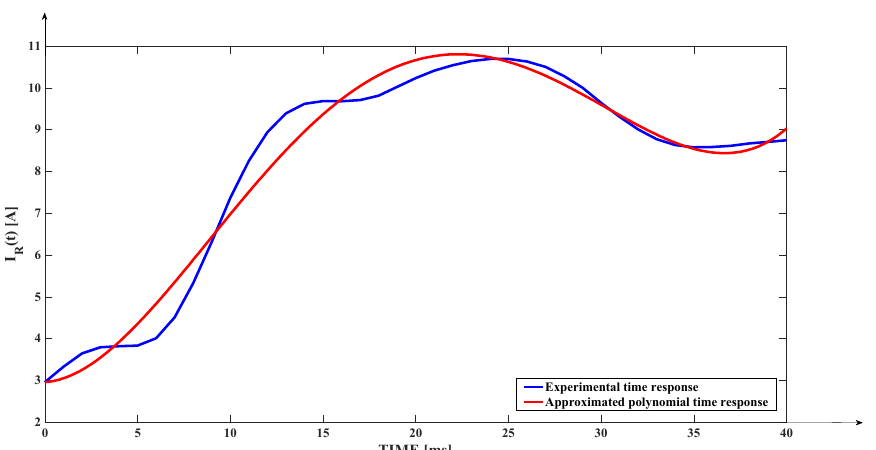
Figure 9. Comparative graph between the experimental response I R (t) and the response of the approximate polynomial model.